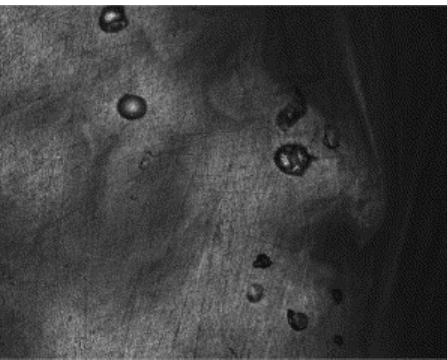
Figure 9. Optical micrograph of the cross-section of APA-6 polymerized at 140 °C. Reprinted from Reference [10], under open-access license.